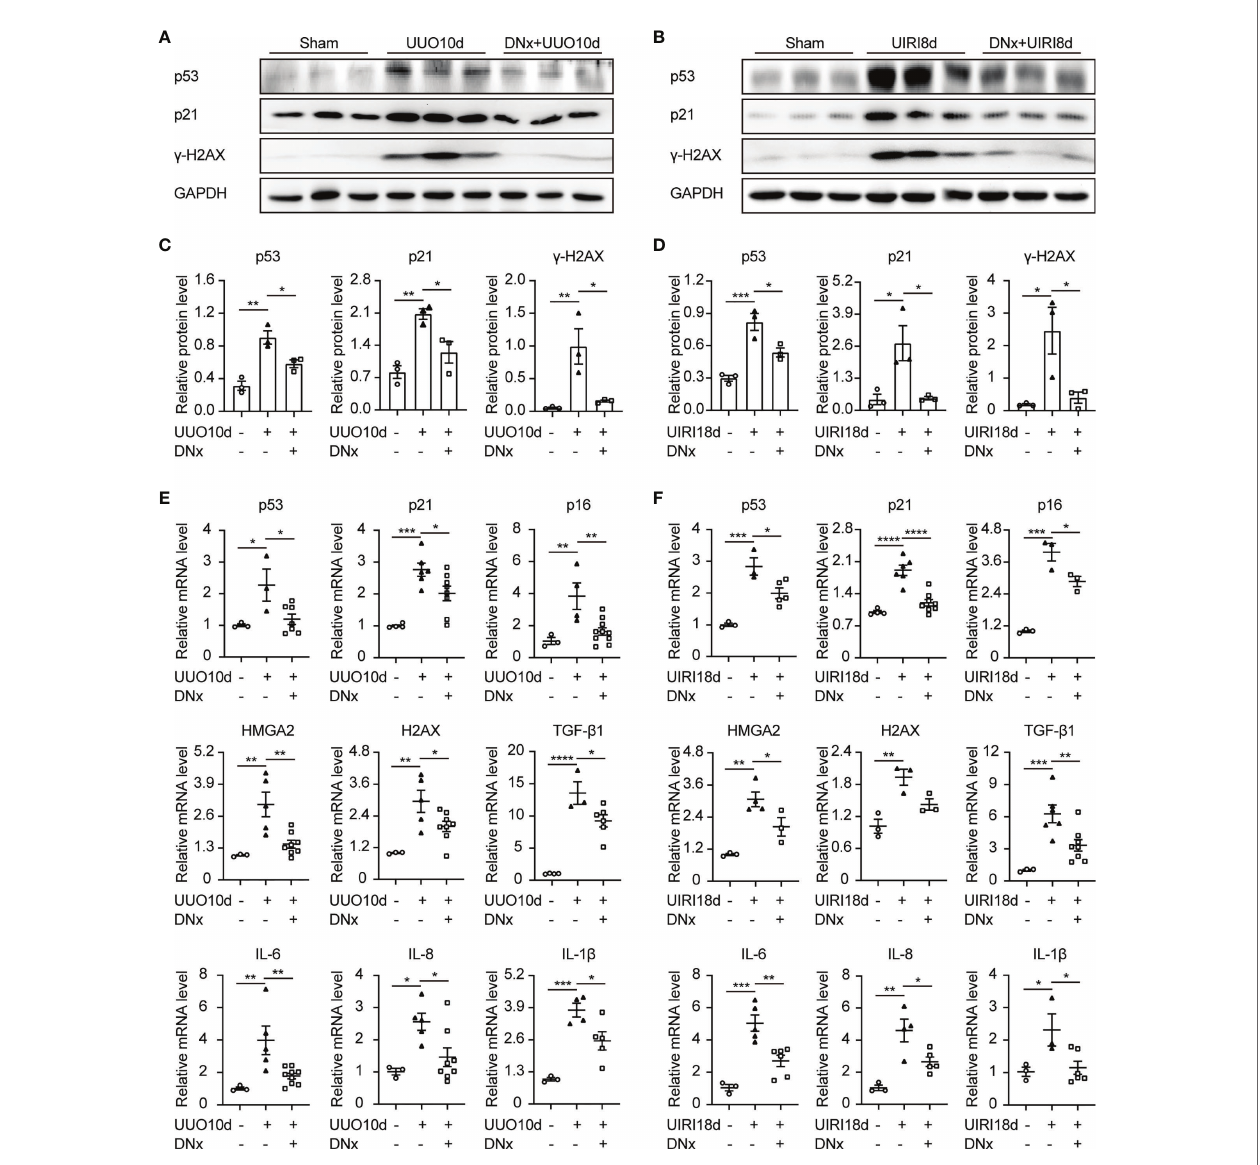
FIGURE 2 | Renal denervation reduces renal senescence and the expression of proin fl ammatory cytokines after kidney injury. Renal denervation (DNx) or sham operation was performed 2 days before the UUO or UIRI model in the left kidneys of mice. (A, B) Representative Western blot of senescence-related proteins p53, p21, and g -H2AX in sham-operated, UUO/UIRI, and DNx+UUO/UIRI kidneys with densitometry analysis (C, D) . (E, F) mRNA expressions of senescence-related markers p53, p21, p16, HMGA2, H2AX, and senescence-associated secretory phenotype (SASP) TGF- b 1, IL-6, IL-8, and IL-1 b in the kidney tissue of sham- operated, UUO/UIRI mice, and DNx+UUO/UIRI mice as shown by qRT-PCR analysis. n=3 – 10 in each group. *P < 0.05, **P < 0.01, ***P < 0.001, ****P < 0.0001. Bars represented means ±